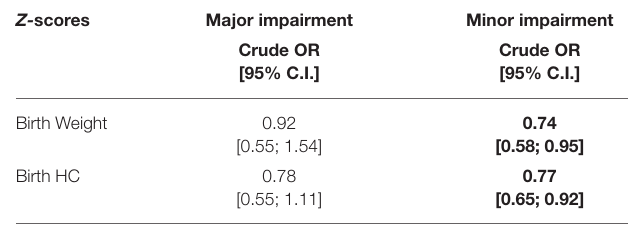
TABLE 3 | Neurodevelopmental outcomes of very preterm infants ( N = 195) at 24 months of corrected age. Major neurodevelopmental impairment, n (%)*